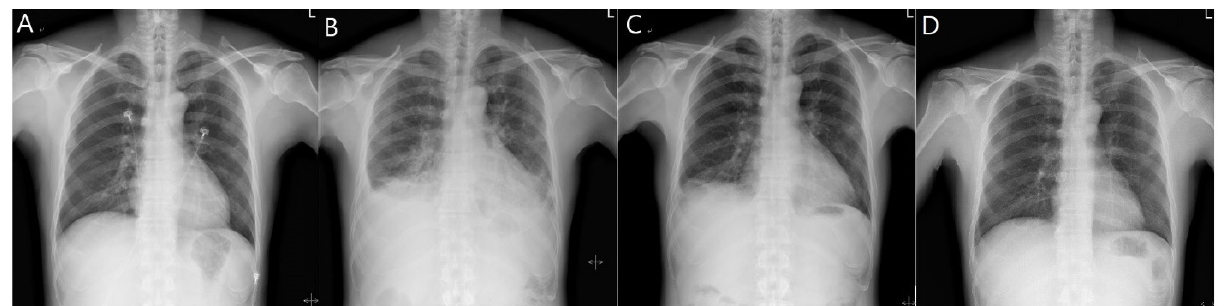
Figure 2. Changes in plain chest radiography (PA) with the clinical course. ( A ) No active disease at the time of admission. ( B ) Deterioration during hospitalization (6 days after admission); pneumonia or pulmonary edema; bilateral pleural effusion or thickening. ( C ) Improvement in pulmonary edema 13 days after admission. ( D ) No active disease at the time of outpatient follow-up (7 days after discharge).